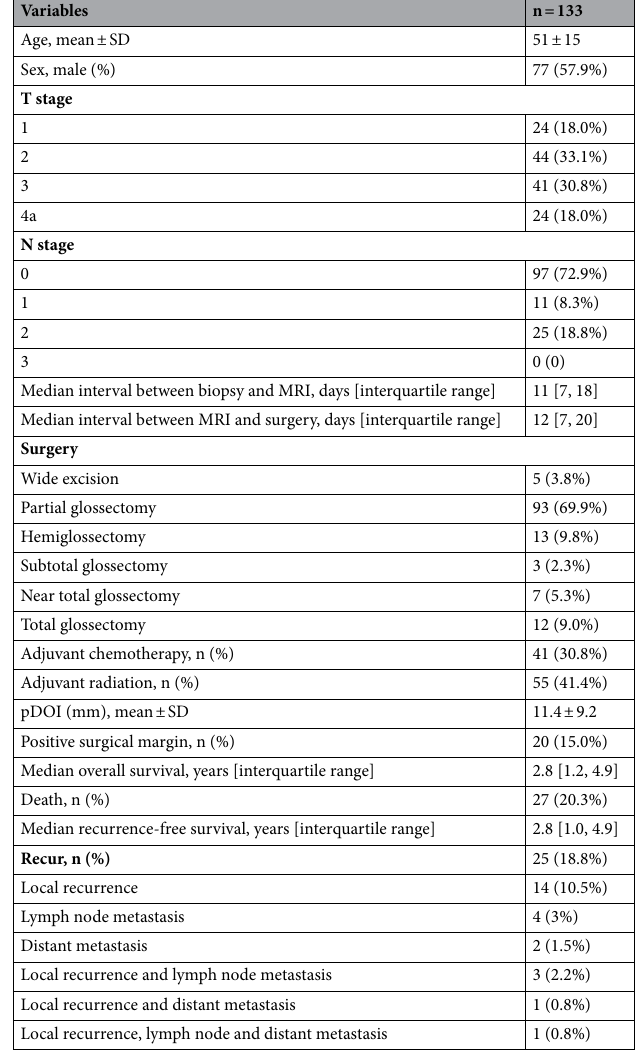
Table 1. Baseline characteristics of study cohort. pDOI pathologic depth of invasion, SD standard